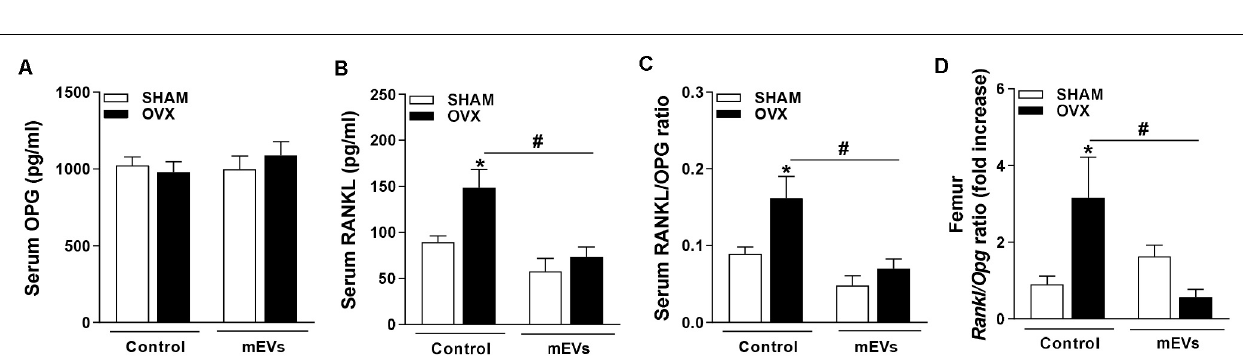
FIGURE 5 | Effect of milk extracellular vesicle treatment in the OPG/RANKL axis in serum and femur. Serum levels of (A) osteoprotegerin (OPG), (B) receptor activator of nuclear factor κ B ligand (RANKL), and (C) RANKL/OPG ratio. (D) mRNA expression of Rankl / Opg ratio in the femur. Analyses were performed in mice (i) pseudo-operated (SHAM) or (ii) ovariectomized (OVX), (iii) non-treated (control), or (iv) treated with milk extracellular vesicles (mEVs). Values are means ± SEM of 6–8 animals per group. * vs. respective SHAM group and # vs. non-treated